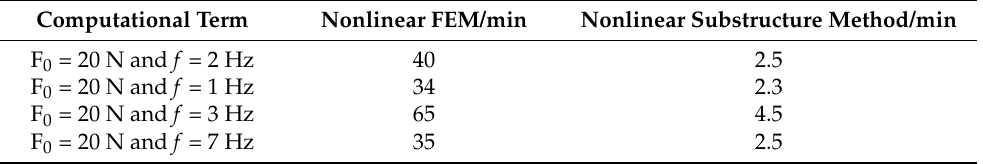
Table 5. Computational time with different method. Computational